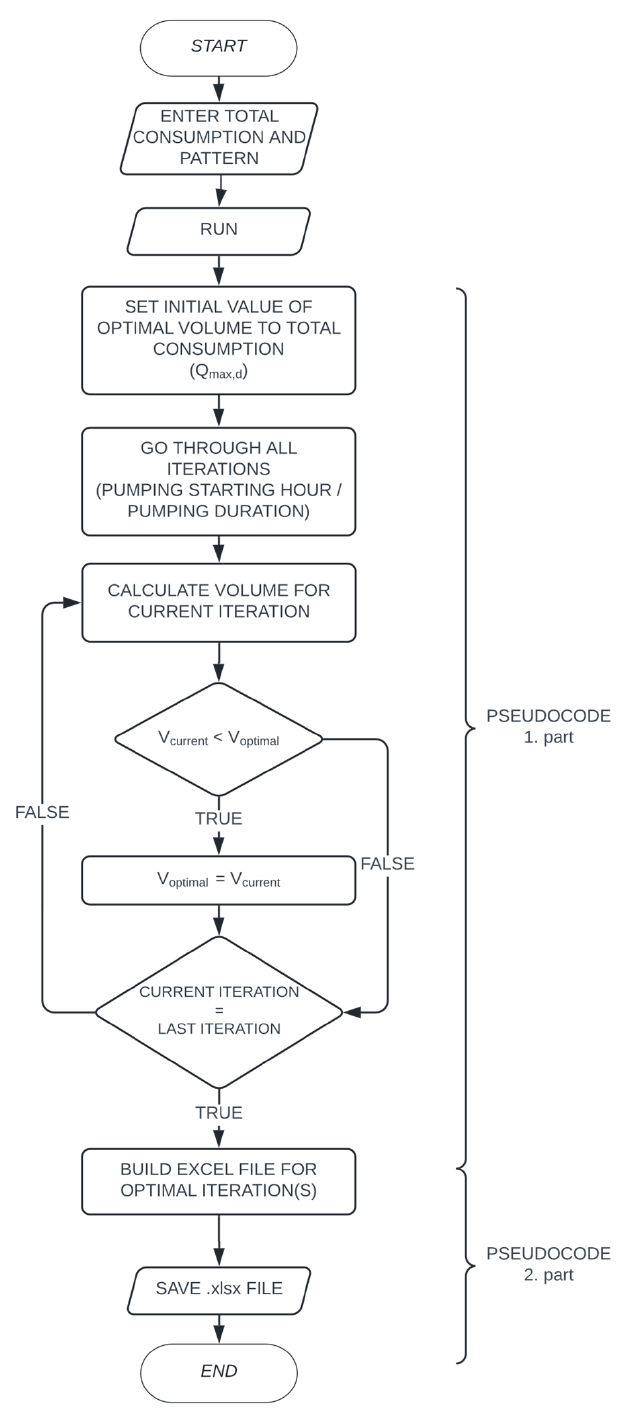
Figure 1. The flowchart of the calculation procedure within the developed application.